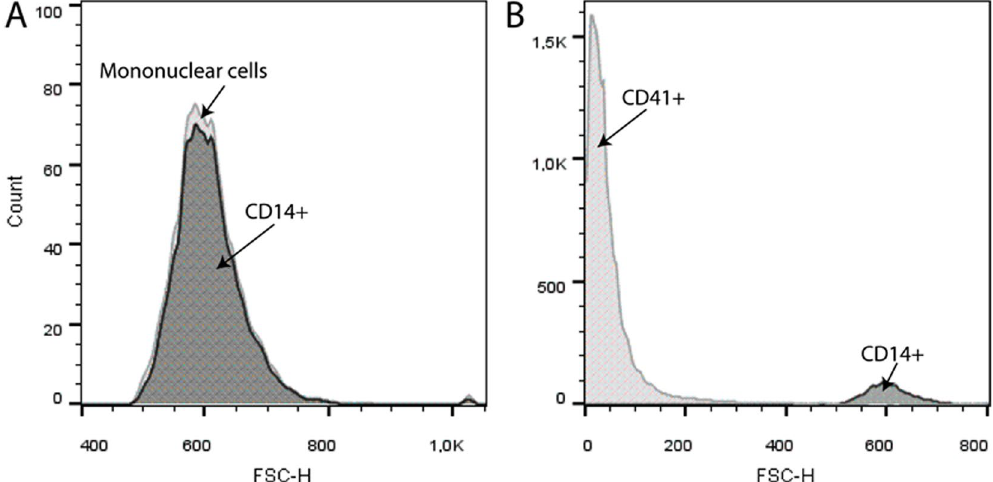
Figure 3. Flow cytometry of isolated monocytes. Representative raw data of a flow cytometry experiment with a freshly isolated monocyte preparation incubated with mouse anti-human CD14 antibodies (monocytes are CD14-positive) and mouse anti-human CD41 antibodies (platelets are CD41-positive) for 30 min at 4 °C in the dark. The preparation contains ~98% CD14 + monocytes (( A ) dark grey) of all mononuclear cells (( A ) light grey). The ratio of CD14 + monocytes (( B ) dark grey) to CD41 + platelets (( B ) light grey) is roughly